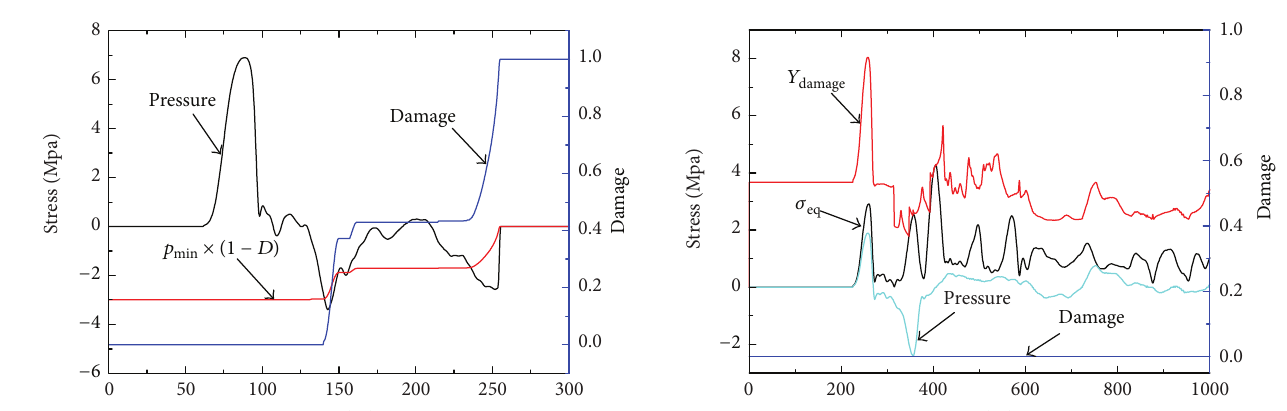
the minimum failure pressure − 3.0 Mpa, enabled the materi- als to fail in tensile stress. Subsequently, the damage did not than the minimum failure pressure. At the time of 234 𝜇 s the